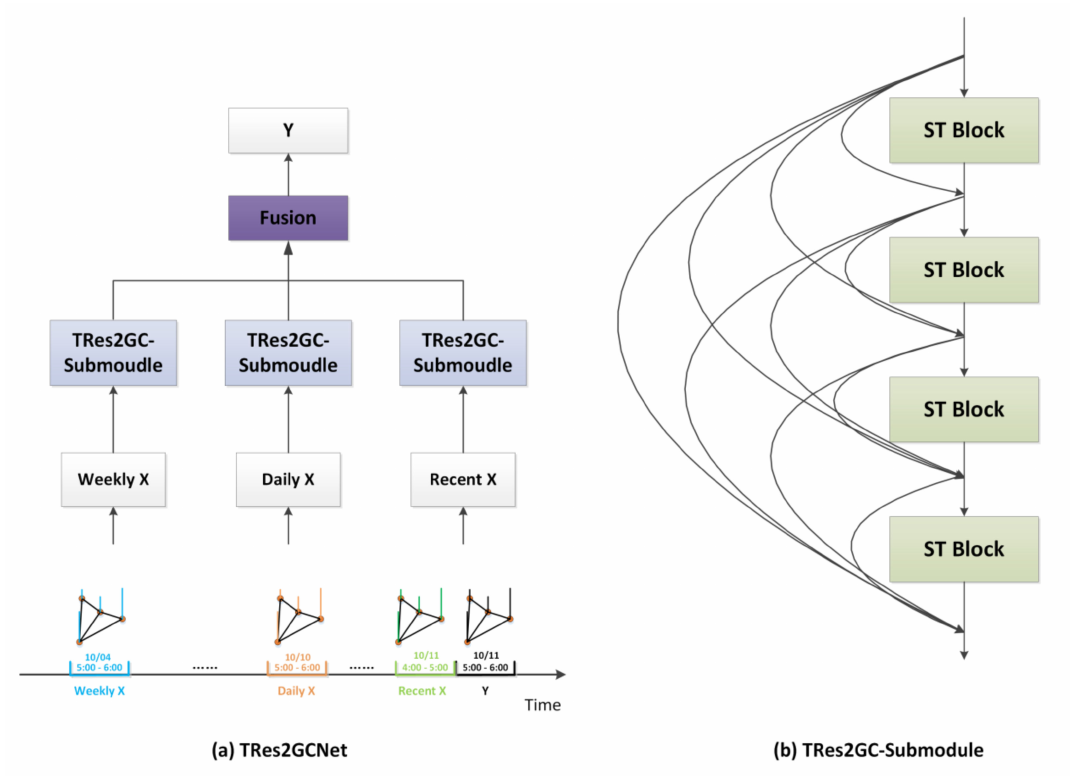
Figure 1. The framework of ( a ) TRes2GCN and ( b )